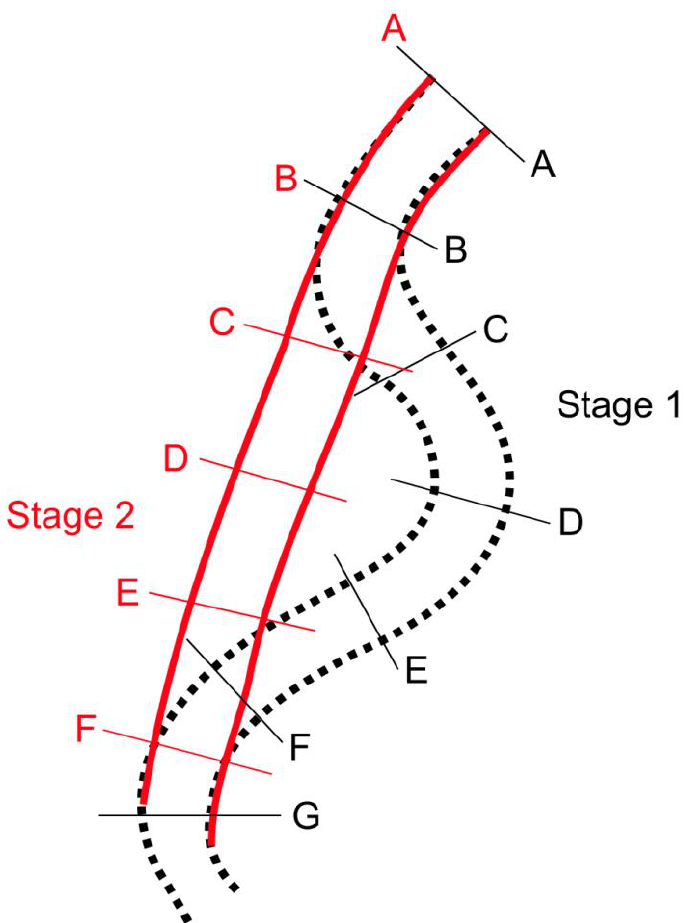
Figure 3. Mismatch of equidistant cross-sections. Diachronic monitoring of the watercourse devel- opment using cross-sections (A–G) surveyed perpendicular to the flow axis and equidistant and considering a river passing from meandering pattern (Stage 1) to straight pattern (Stage 2). The number of sections varies from one watercourse to another if the cross-section’s equidistance is respected. This method based on the comparison of equidistant cross-sections does not work as long as the channel varies in length over time. In any case, it is not possible to draw up cross-sections in the same place when the channel deforms laterally and